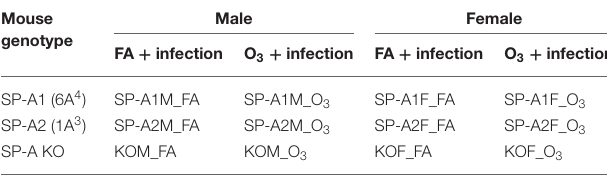
TABLE 1 | Experimental